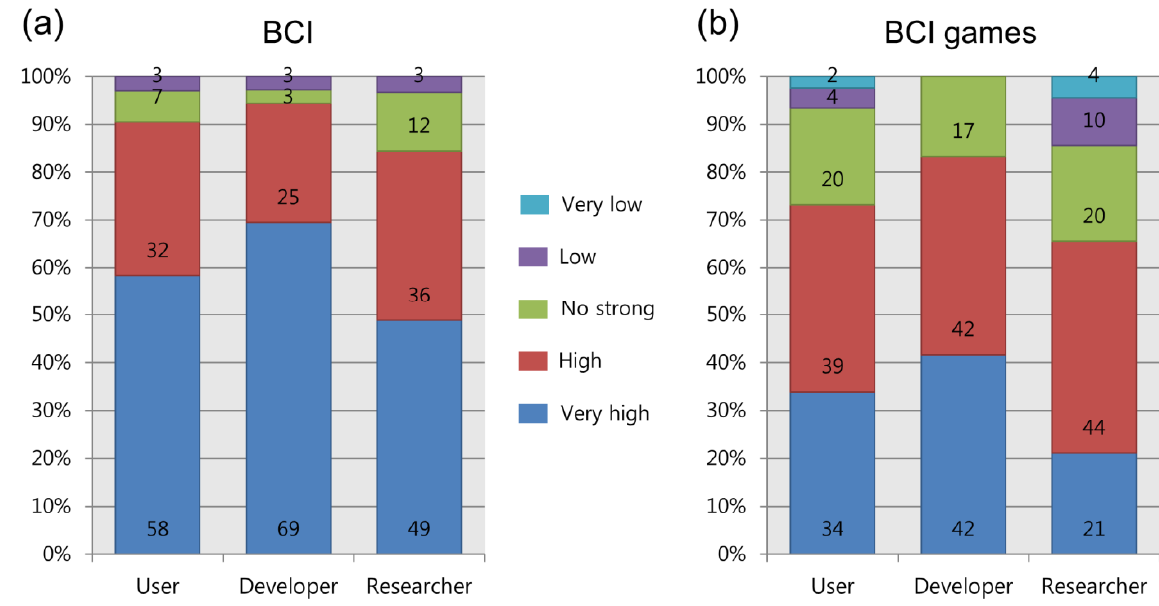
Figure 6. Respondents’ evaluations of the influence of BCI ( a ) and BCI games ( b ). All three groups answered that BCI and BCI games would have a considerable influence in the future. The percentages were calculated by